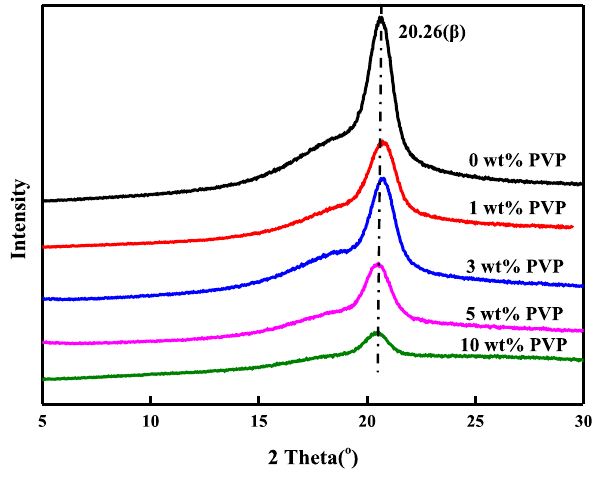
Fig. 10 XRD results of PVDF membranes produced with different PVP